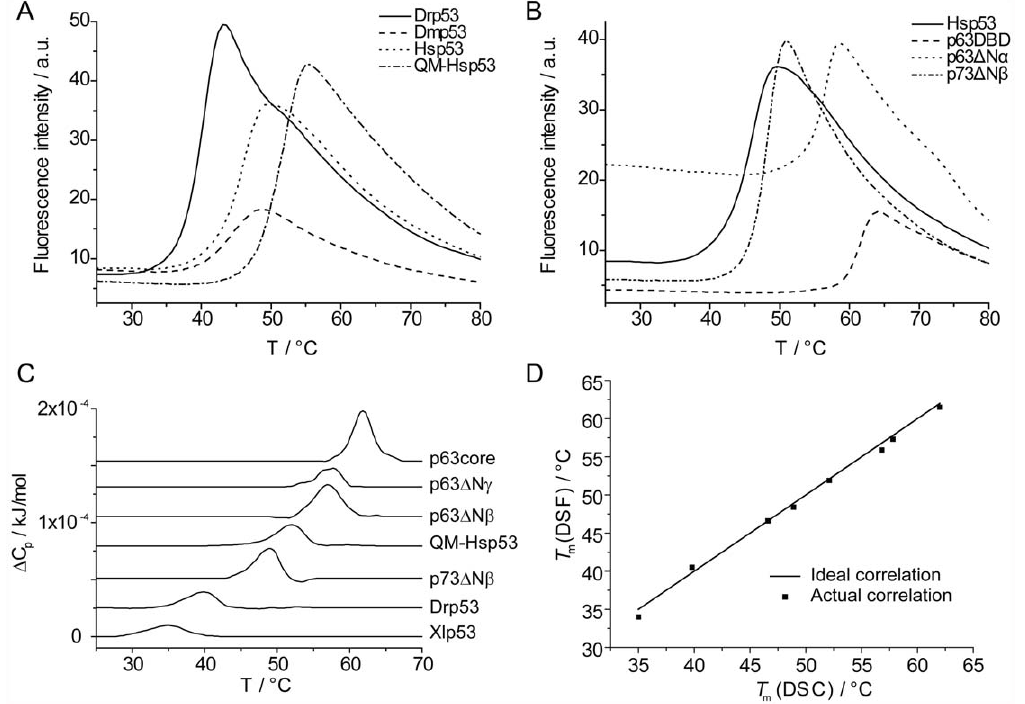
Figure 4. Thermodynamic stability determination. A: Examples of raw data melting curves for p53 orthologs derived from DSF experiments. T m is defined as the maximum of the first derivative. B: DSF melting curves for p53 paralogs. C: Stacked view of DSC melting curves. D: Correlation of melting temperatures derived by DSF and DSC.